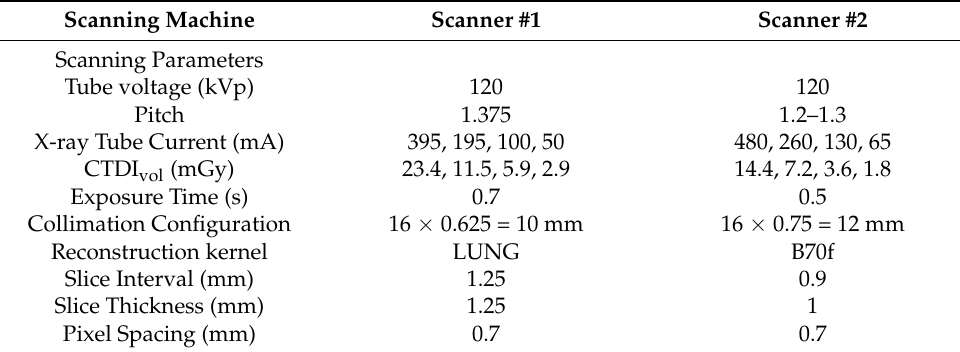
Table 1. Scan conditions used in CT data